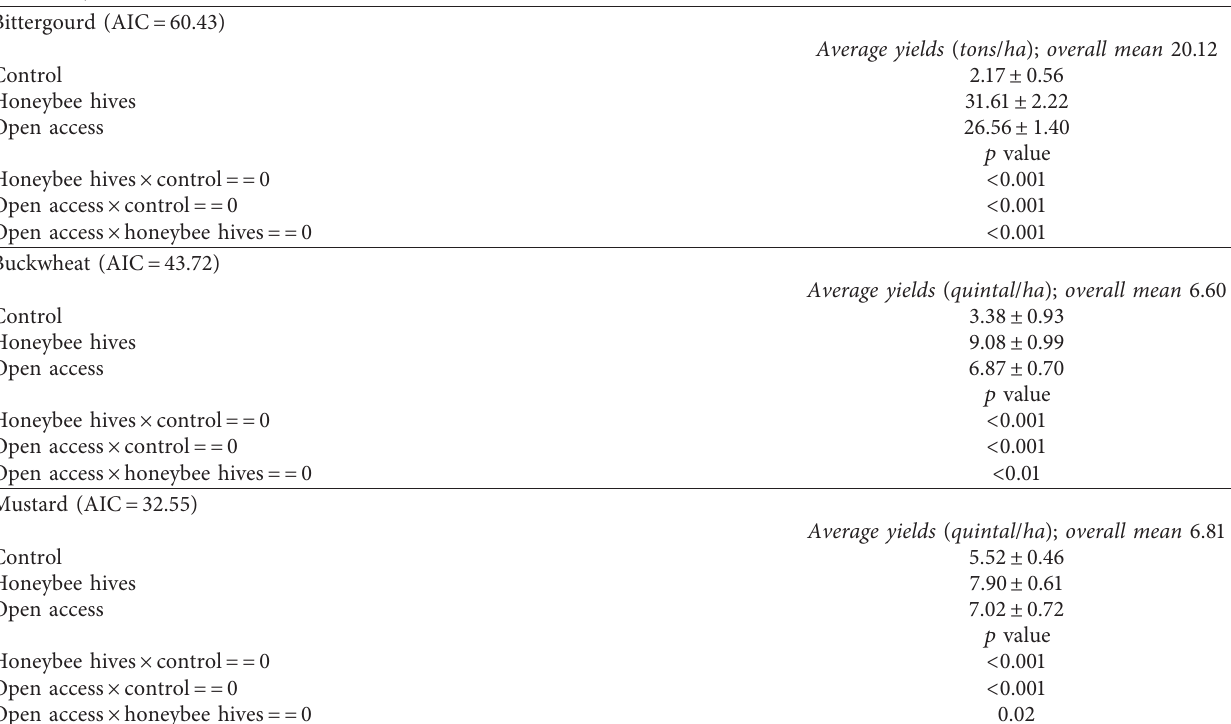
Table 1: Results of the generalized linear model for yields of three crops in Nepal according to three experiments performed in bittergourd, buckwheat, and mustard